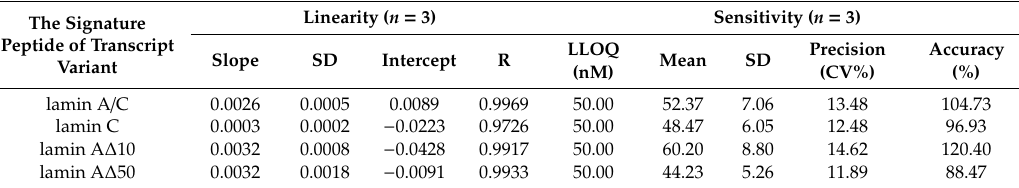
Table 4. Linearity and sensitivity ( n = 3).